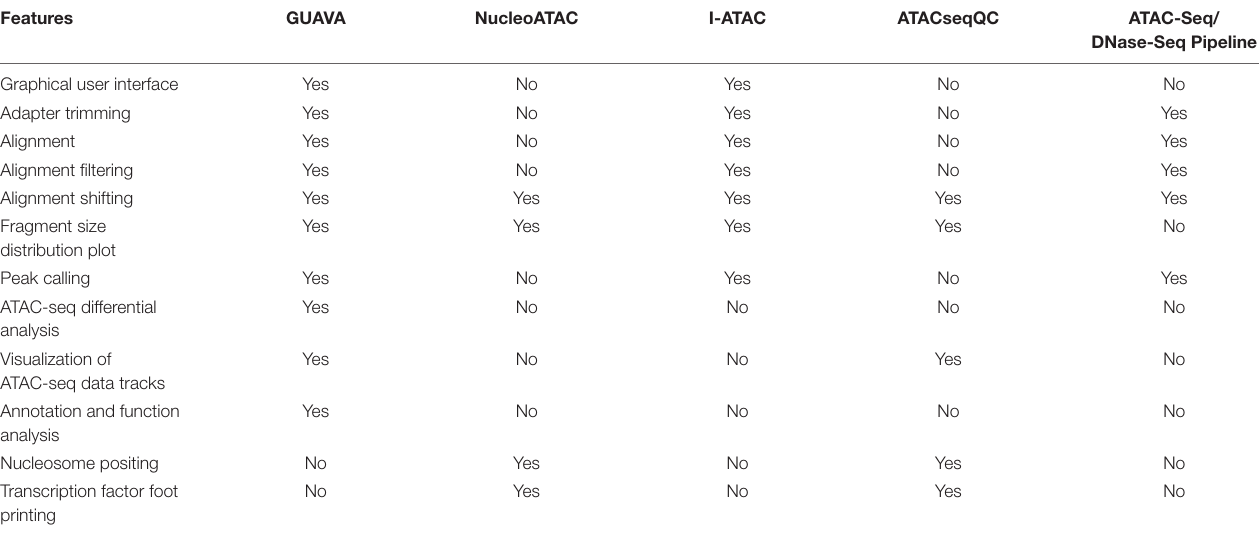
TABLE 1 | Comparison between GUAVA and available tools for ATAC-seq data analysis. Features ATAC-Seq/